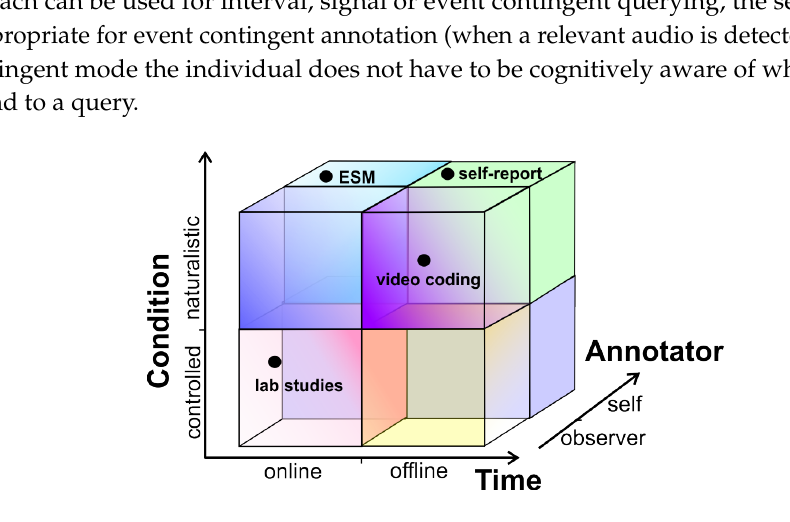
Figure 1. Annotation approaches classified in three dimensions: Time, author of the annotation and ecological